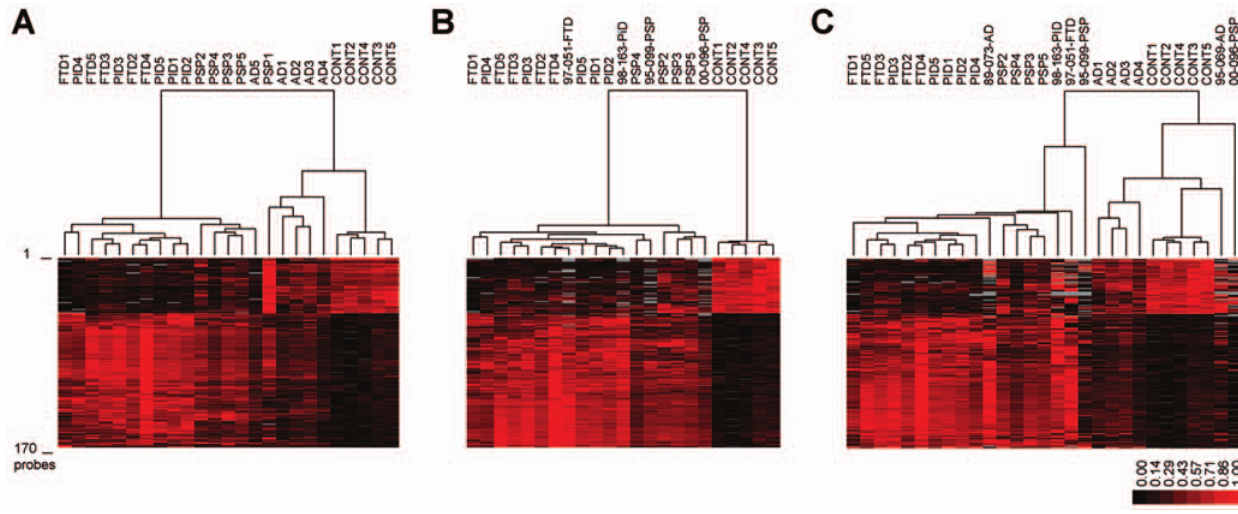
Figure 2. Analysis of original and new samples using the refined microarray data set. Figure 2A. Clustering of all 25 samples using the refined dataset of 166 probes. Figure 2A. Clustering of selected 23 samples and new PSP, FTD and PiD disease samples. Figure 2C. Clustering of selected 23 samples and new PSP, FTD and PiD - and Alzheimer’s disease samples. Sample names are as in Figure 1.